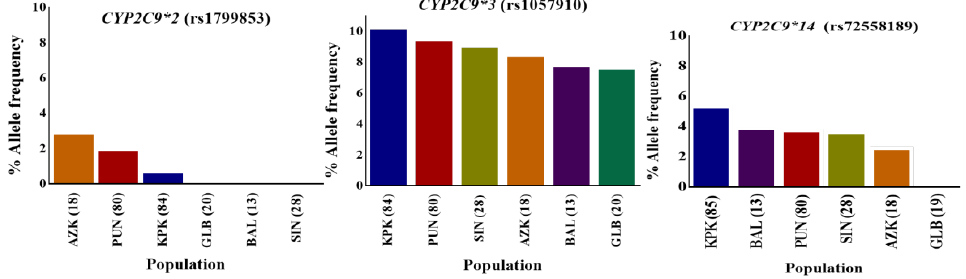
Figure 2. CYP2C9*2 , CYP2C9*3 , and CYP2C9*14 variant allele distributions in indigenous Pakistani populations. The distribution of the percentage allele frequency of pharmacogenetic CYP2C9*2 , CYP2C9*3 and CYP2C9*14 variants in Pakistani local populations. Regional populations are